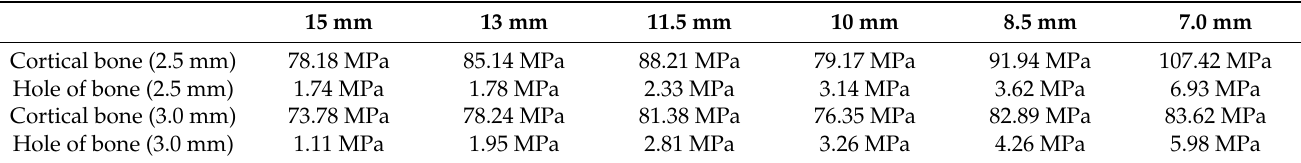
Figure 10. Von Mises stress on cortical bone, bottom of cancellous bone (3.0 mm). Table 4. Cortical bone, hole in bone 2.5 mm/3.0 mm (axial force) von Mises stress